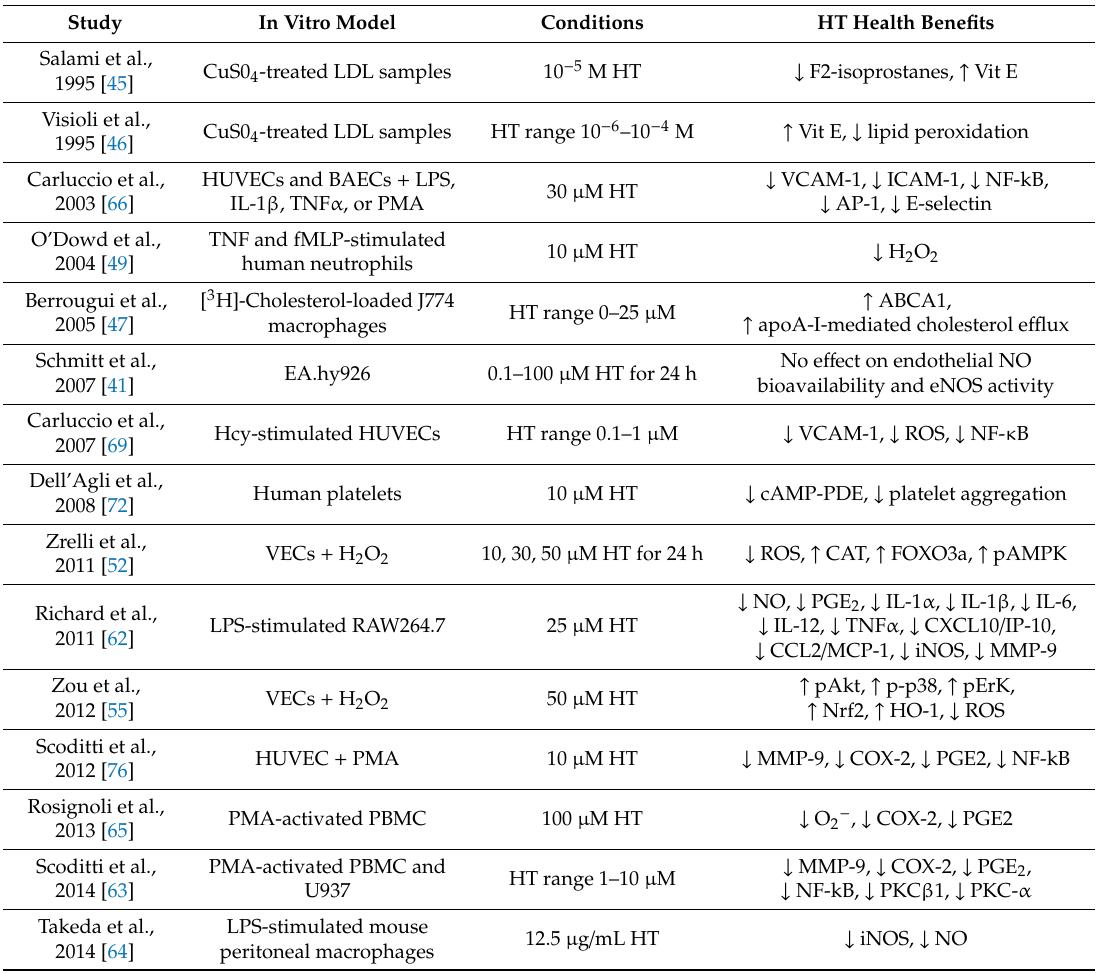
Table 1. Summary of relevant studies of HT in cellular in vitro